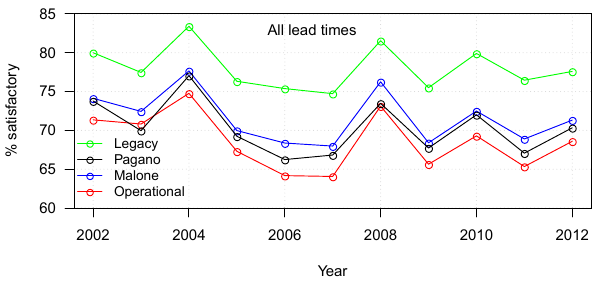
Figure 5. Percentage satisfactory for all lead times and locations for each year ( x axis) using four different benchmarks. Table 3. Contingency table of the forecast versus observed occur- rence of river levels above flood level (defined in Table 1). All loca- tions and years are pooled together due to the rarity of floods. The top table is for 1-day forecasts and the bottom is for 5-day fore- casts. Forecasts are only included if observed river level was below flood level at the time of forecast issuance. Also shown are the false alarm rate (FAR), probability of detecting floods (POD), and equi- table threat score